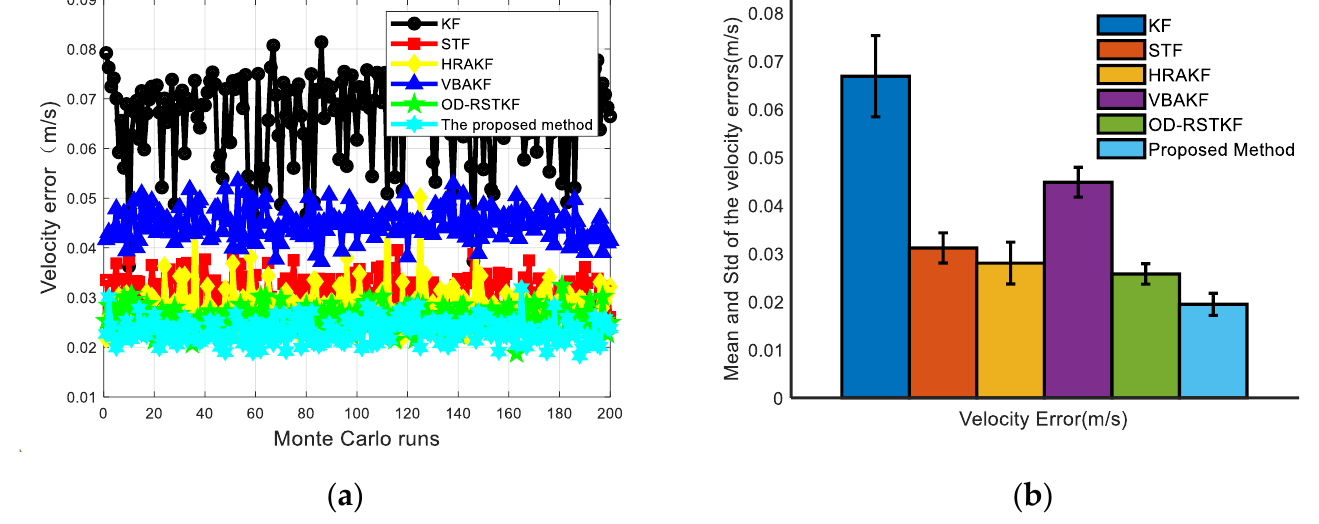
Figure 7. Heading error results of various filters ( a ) Heading angle error of various filters under 50 Monte Carlo simulations; ( b ) Mean and STD of heading angle errors of various filters under 50 Monte Carlo simulations.